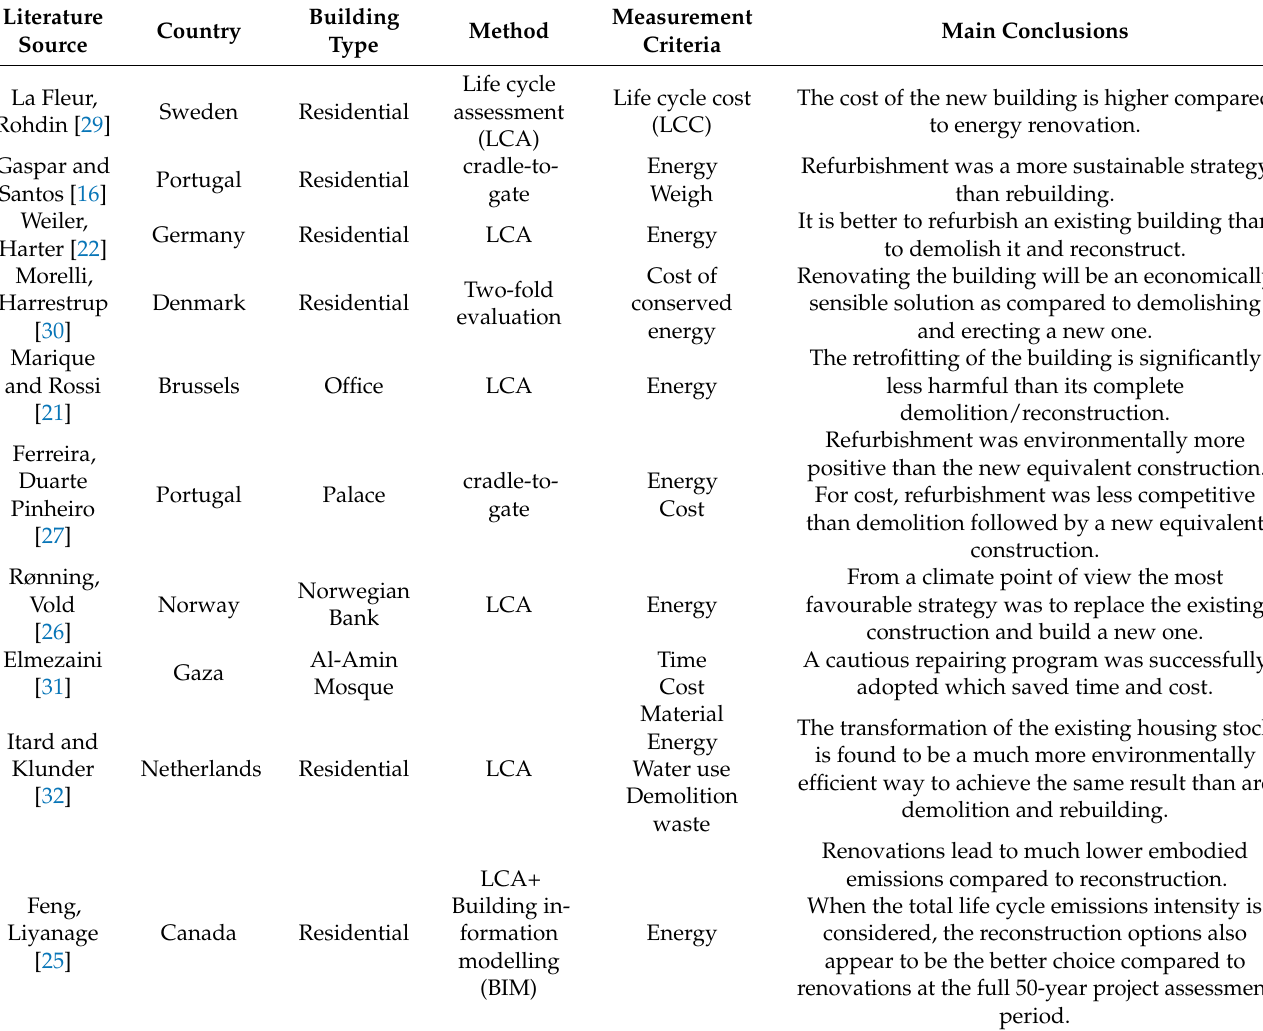
Table 1. Recent studies on comparison of rebuilding and